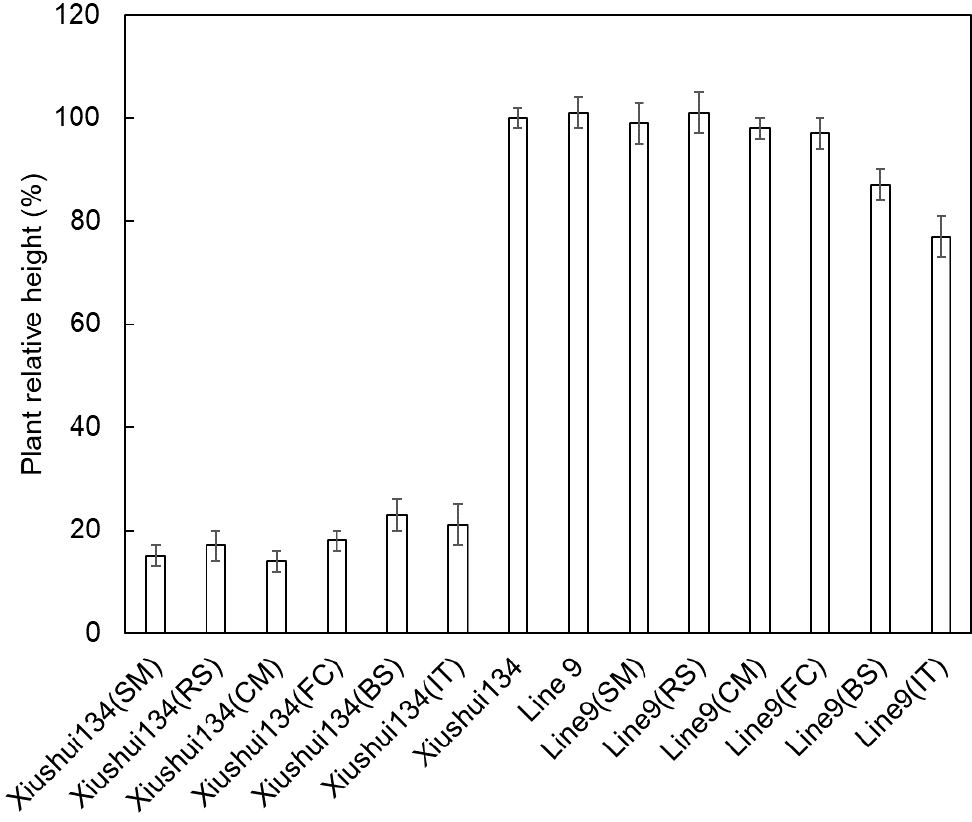
Figure 8. Plant relative height of Xiushui134 and Line9 at the seedling stage. The Xiushui134 plants were killed with herbicide treatments, and the relative heights were around 20%. The Line9 plants grew well with SU herbicide treatments. The growth of Line9 was inhibited by a PYB (BS) and IMI (IT) herbicides. Error bars represent the errors from multiple measurements.